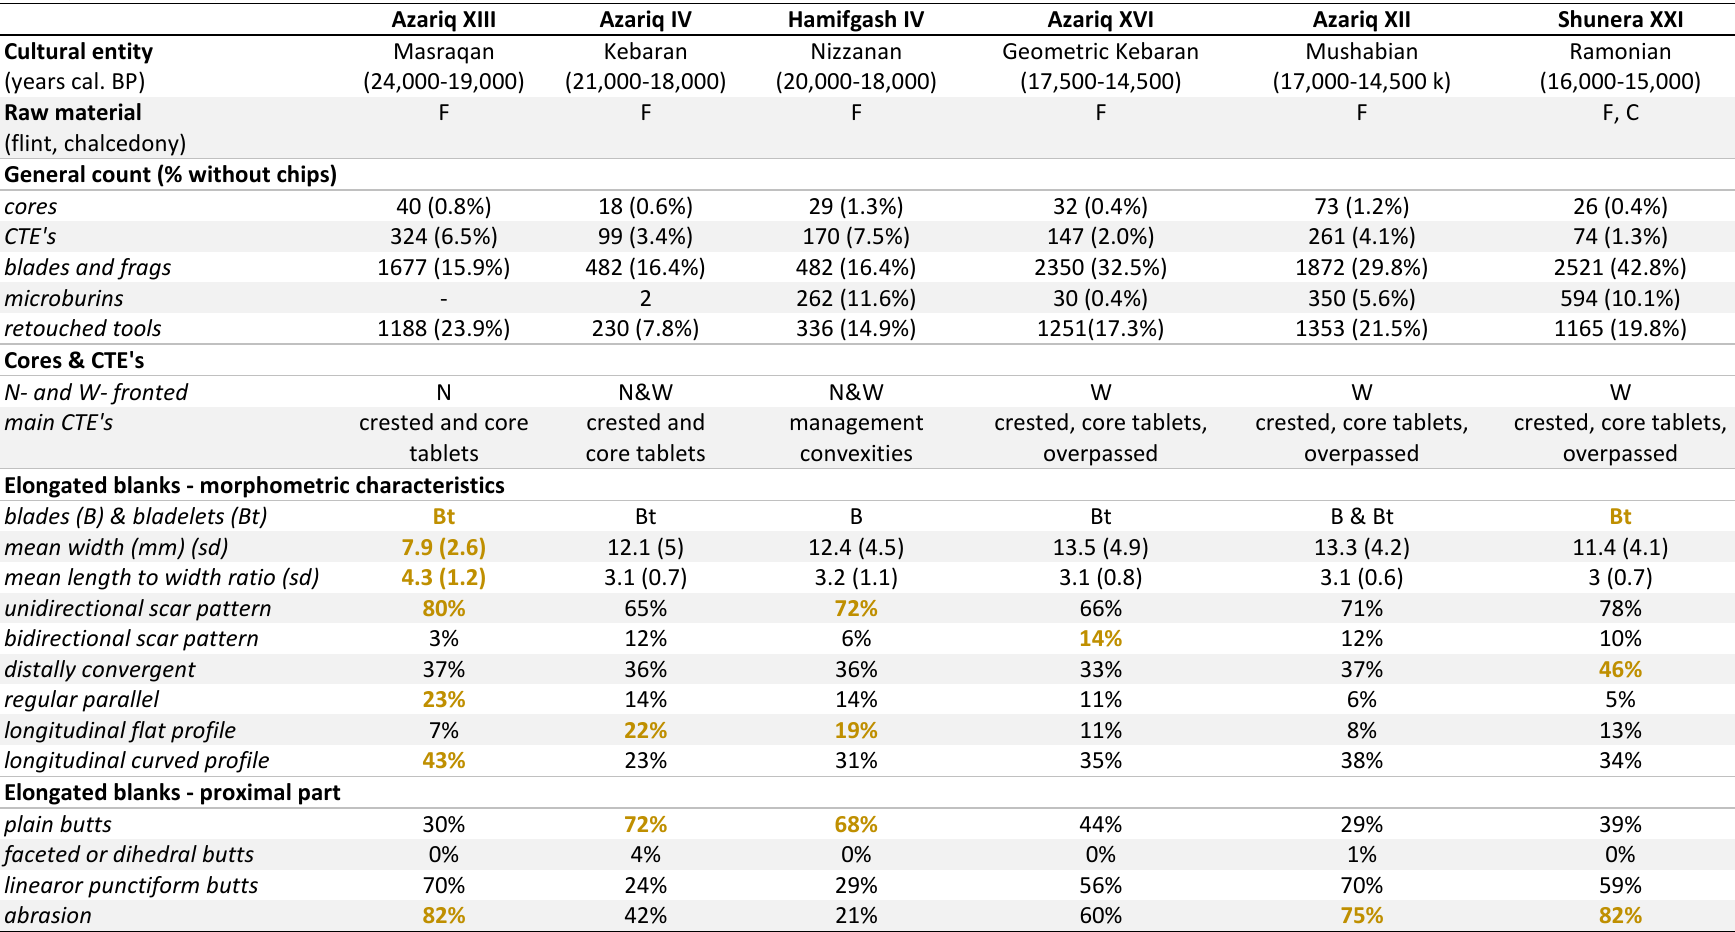
Table 14. Main characteristics of the lithic assemblages studied. Abbreviations: F - flint, local sources; C - chalcedony, more distant sources; CTE - core trimming element; B - blades; Bt - bladelets; sd - standard deviation; Azariq XIII Azariq IV Hamifgash IV Azariq XVI Azariq XII Shunera